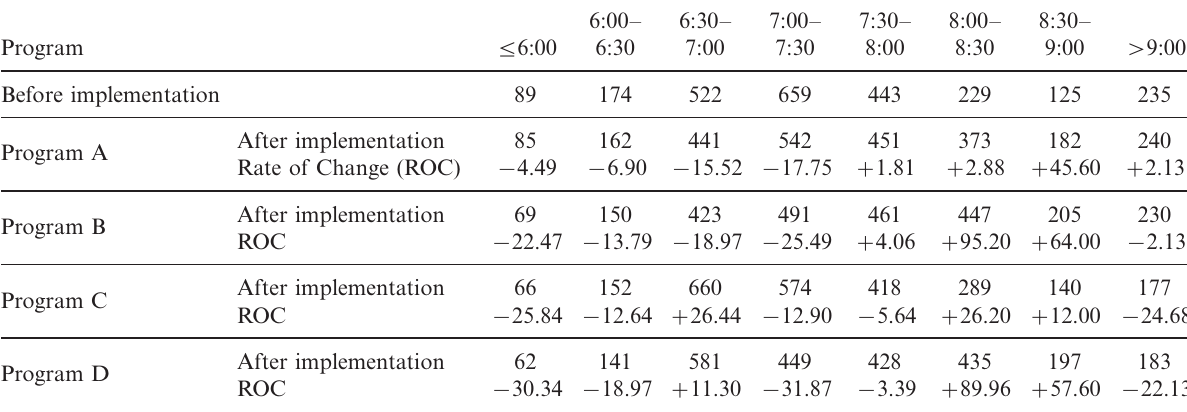
Table 9. Departure time analysis of the integrated programs